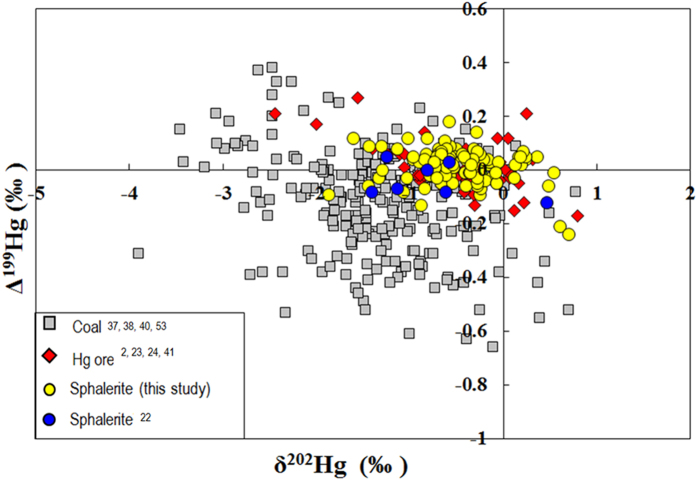
Δ199Hg versus δ202Hg in sphalerites, Hg ores and coal deposits.